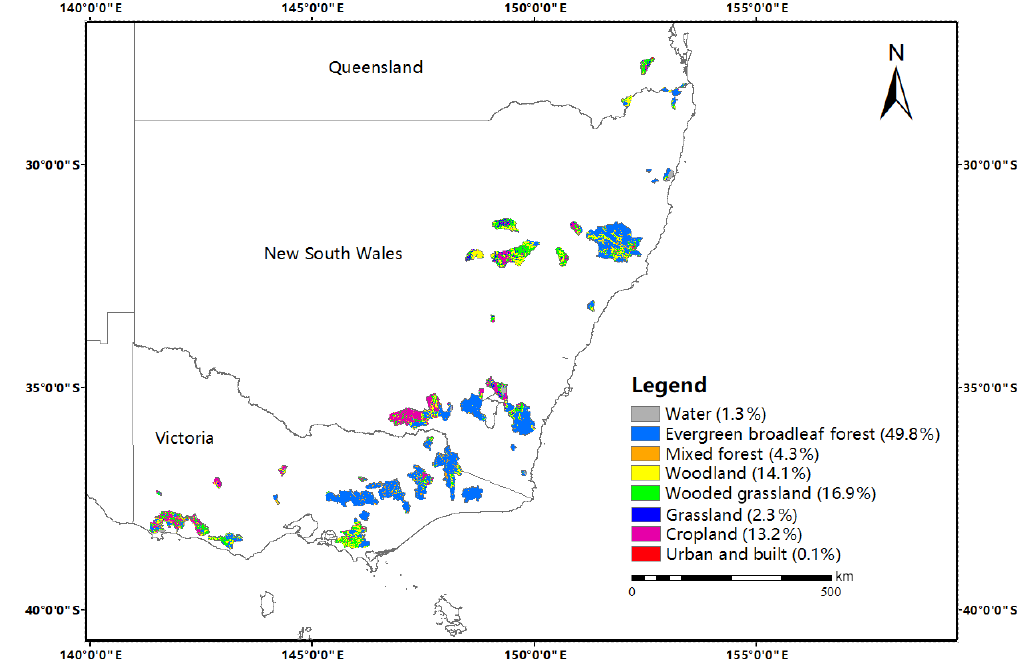
Figure 13. Land use types and corresponding percentages in the study catchments (83 catchments). The land use data were adopted from the global land cover map at 1km resolution released by the University of Maryland (Hansen et al.,